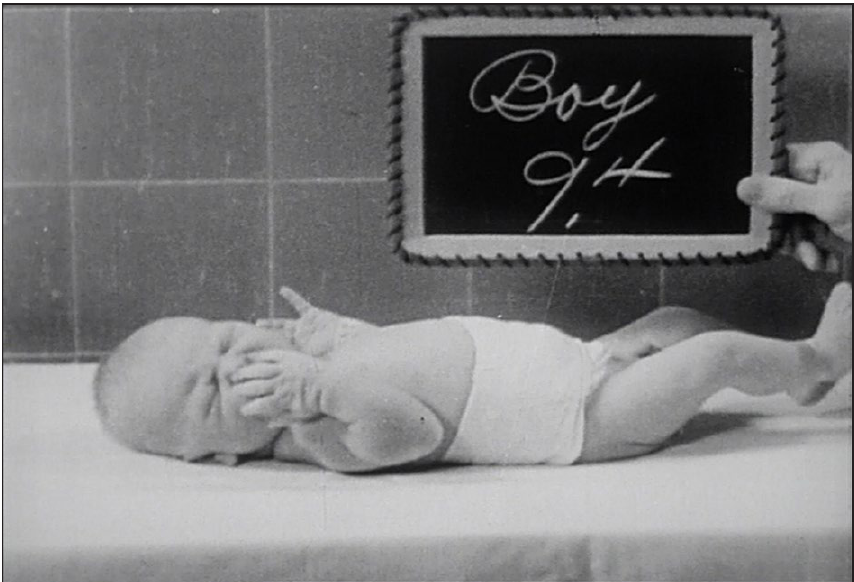
Figure 26: Irene Lusztig, The Motherhood Archives , single channel HD video,